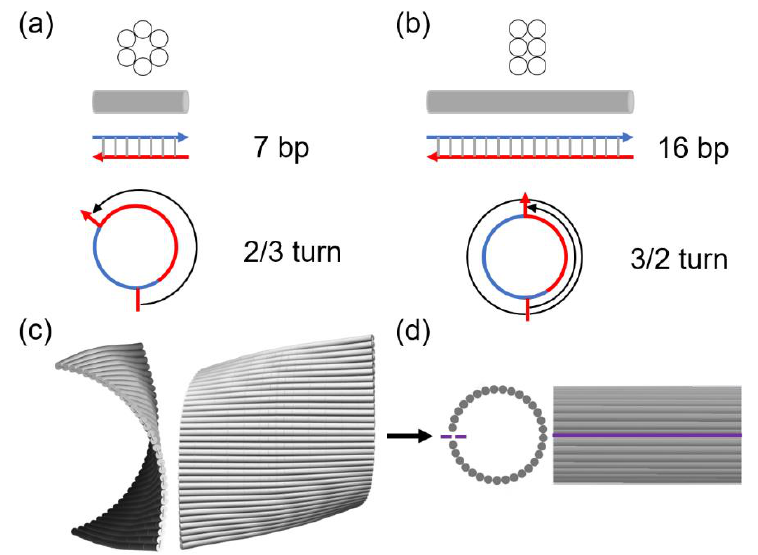
Figure 3. Schematics and FEM simulation results of DNA origami. Comparison of ( a ) honeycomb and ( b ) square lattice designs. The gray cylinder represents a dsDNA bundle from the lattice. The blue and red lines with arrows indicate the scaffold and staple strands, respectively, with their 3’ ends marked as arrows. In a honeycomb lattice, crossovers can be placed every 7 bp which is accounted for 2/3 turns in the axial direction of a dsDNA bundle. This corresponds to 10.5 bp/turn, consistent with the helicity of native B-form DNA. In a square lattice, however, a possible crossover is arranged in every 16 bp or 3/2 turns, yielding 10.67 bp/turn. ( c ) CanDo simulation results of a single-layer DNA origami rectangle in a square lattice (side and front views). With the designed helicity at 10.67 bp/turn, the tile has a minor global twist in the FEM simulations at 10.5 bp/turn. ( d ) Schematics of the cyclized DNA origami tile in both views. The purple line indicates the sealed upper and lower boundaries by linker staples in experiments.